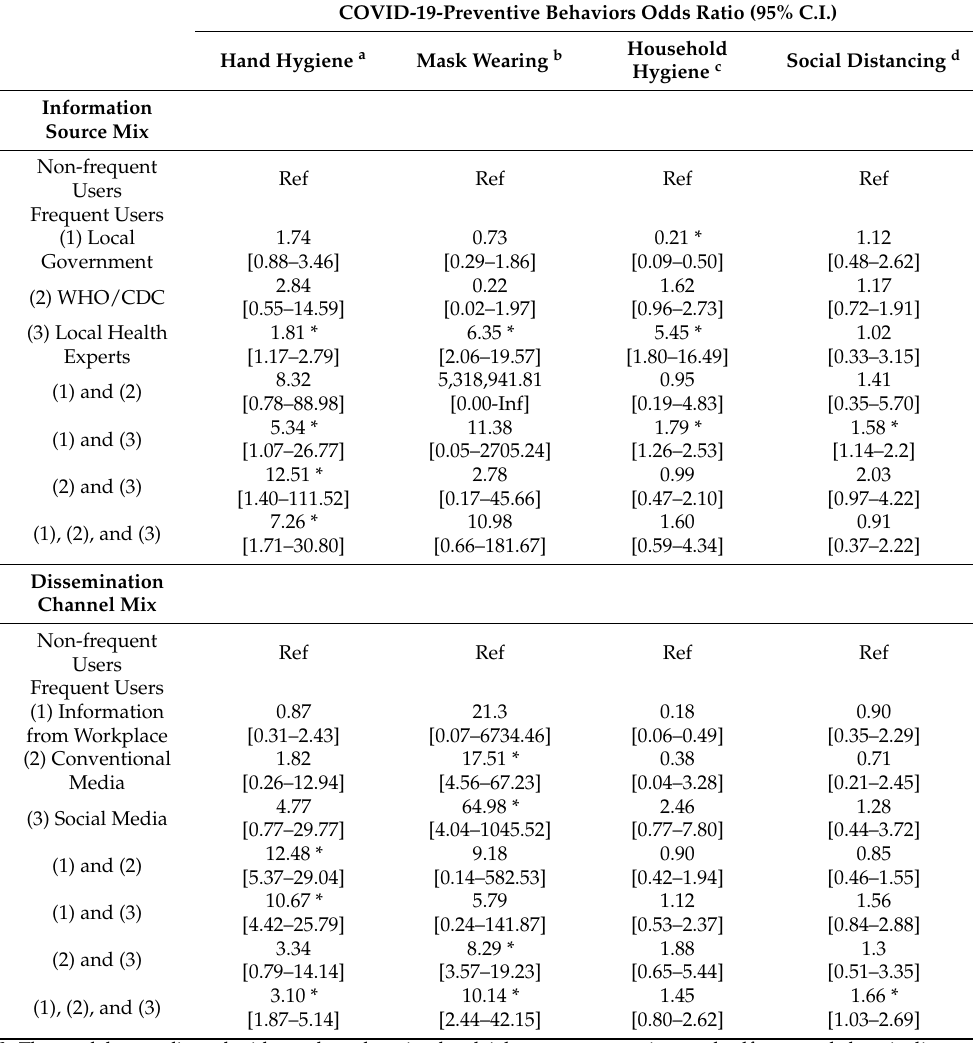
Table 5. Summaries of univariate logistic regressions (weighted with